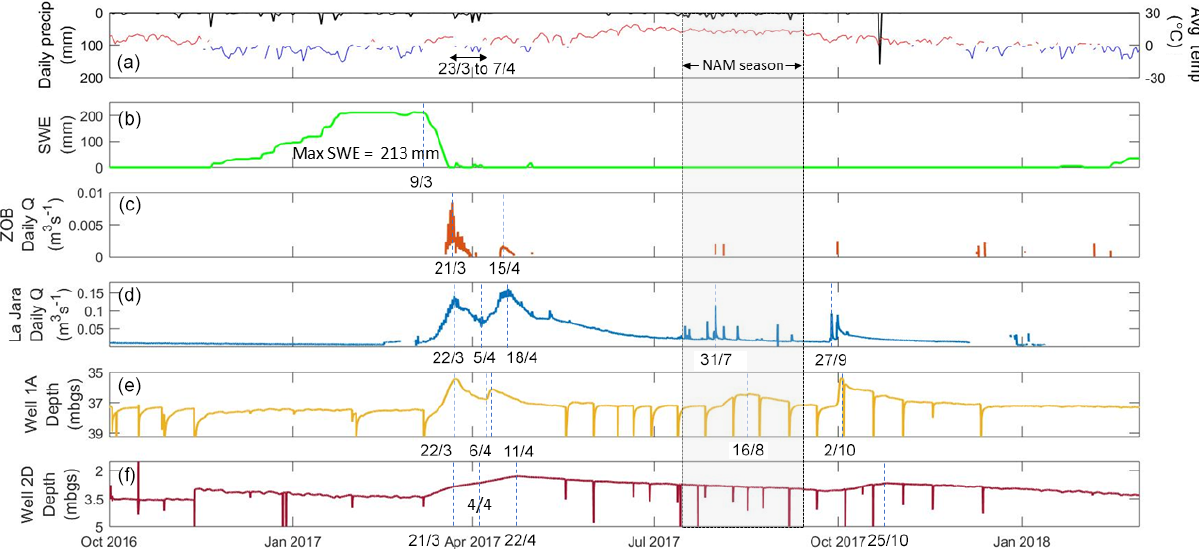
Figure 3. (a) Daily averaged precipitation falls down from the top axis. Average daily temperature is shown in red when temperatures are above 0 and blue at or below 0 ◦ C. (b) Snow water equivalent (SWE) for WY 2017 reaches a maximum of 213mm. (c) Discharge of ZOB flume in 15min intervals for WY 2017. (d) Discharge of La Jara flume in 15min intervals for WY 2017. (e) Well 1A depth of water below the ground surface from a vibrating wire piezometer placed 41.5m below the ground surface in 15min intervals. Drops in water depth correspond to sample collection. (f) Well 2D depth of water below the ground surface from a vibrating wire piezometer placed 6.4m below the ground surface in 15min intervals. Drops in water depth correspond to sample collection. The shaded region marks the timing of the North American monsoon (NAM) season from 15 July through 15 September.